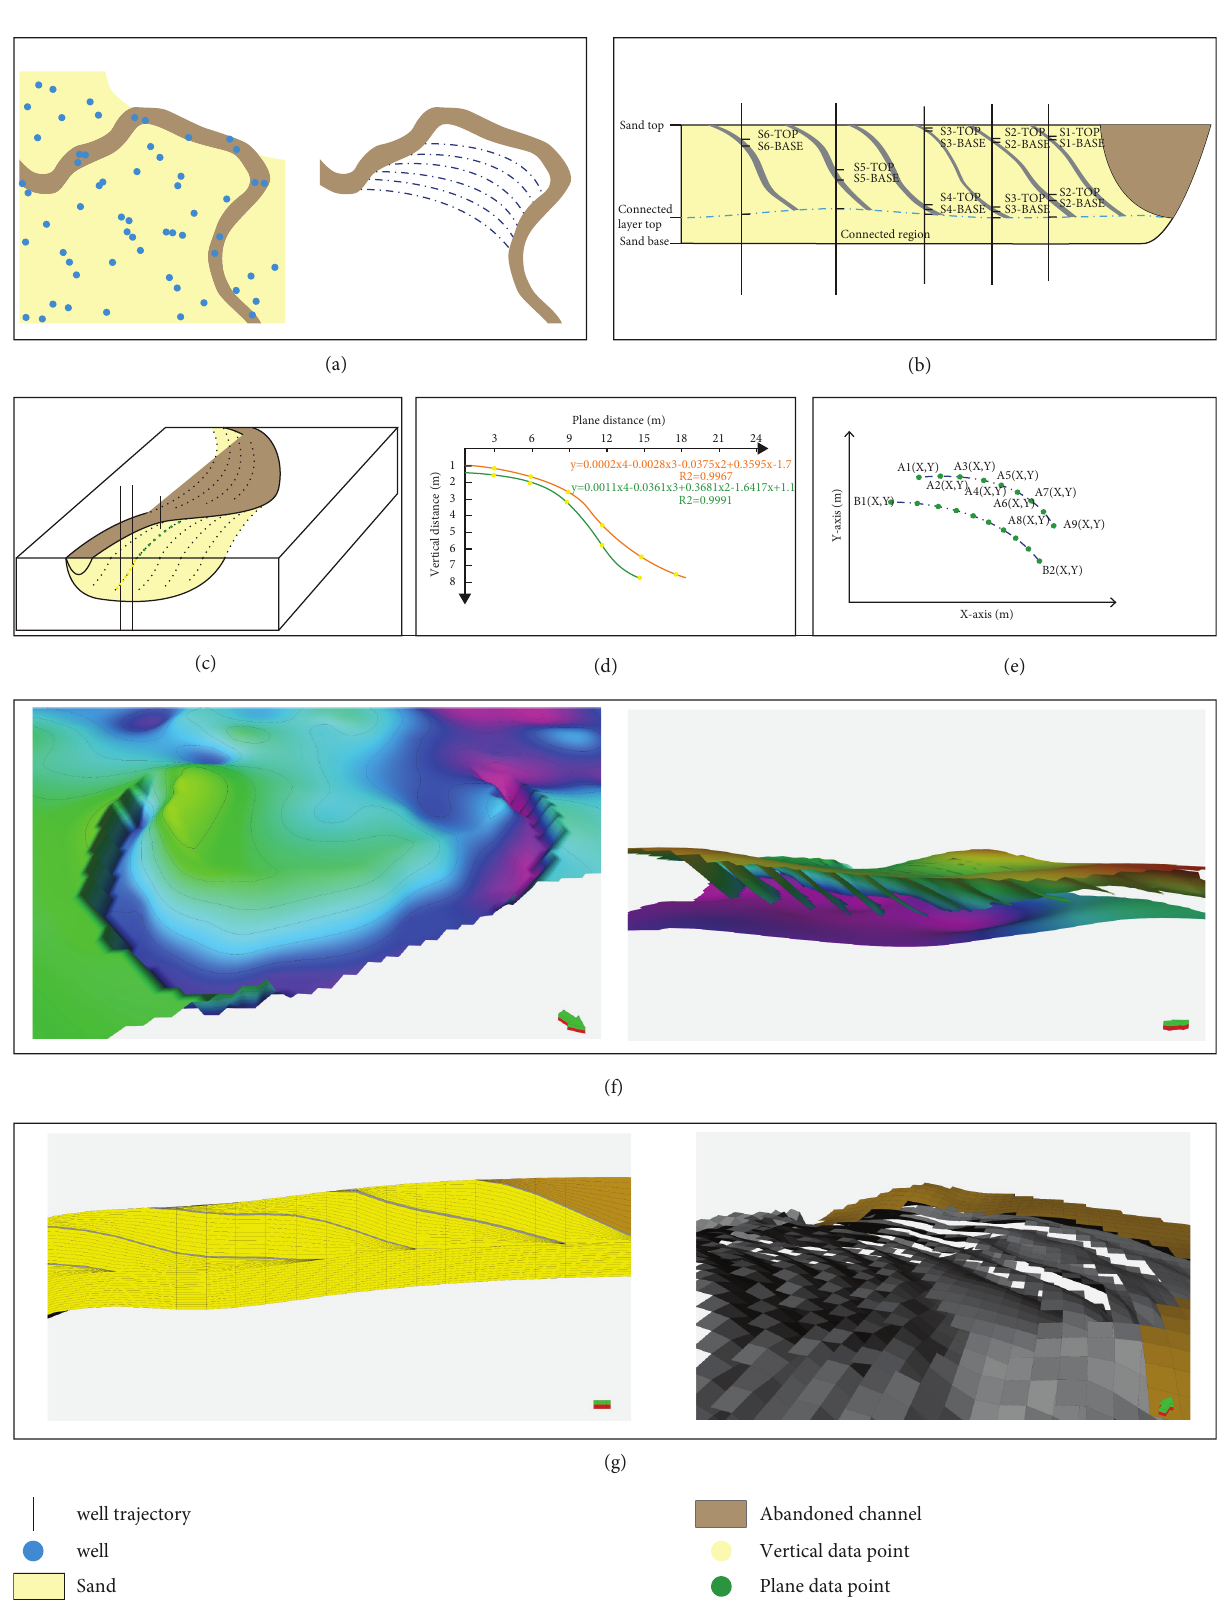
Figure 9: Water injection profiles in different periods under the control of interlayer seepage